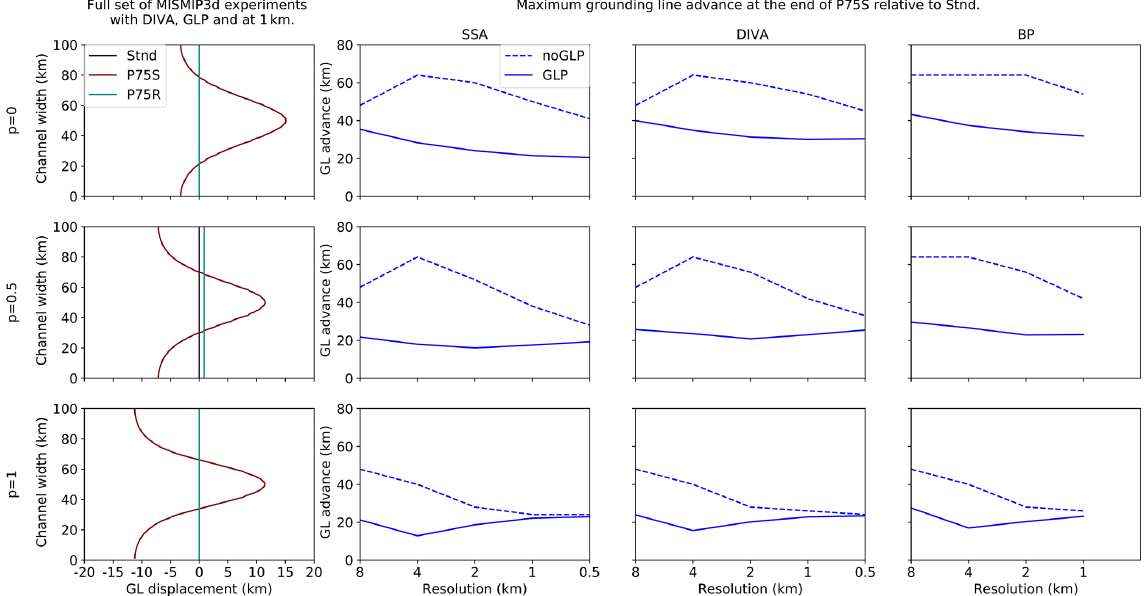
Figure 6. Grounding line profiles for the MISMIP3d experiments. The three rows show results with p = 0 (top), p = 0 . 5 (middle), and p = 1 (bottom). The first column shows the grounding line displacement (km) relative to the end of experiment Stnd for the full set (Stnd (black), P75S (red), and P75R (cyan)) of MISMIP3D experiments using DIVA with a GLP, at a resolution of 1km. The Stnd and P75R positions are visually indistinguishable for p = 0 and p = 1. Columns 2–4 show the most advanced grounding line location at the end of experiment P75S, relative to the end of Stnd, as a function of grid resolution. Columns 2–4 are arranged as in Fig.